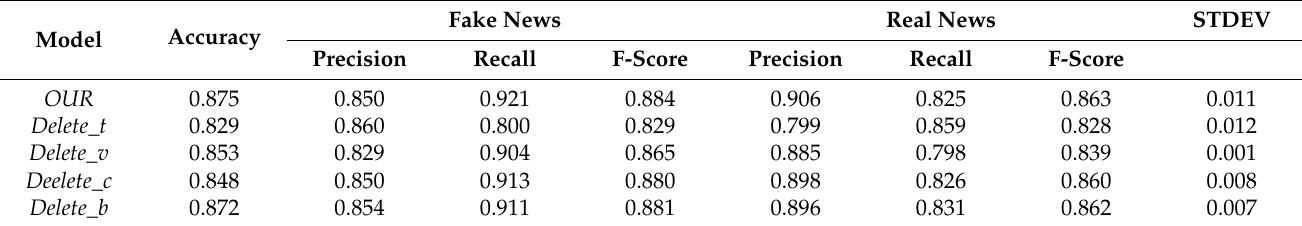
Table 6. Ablation experiments on Weibo dataset.